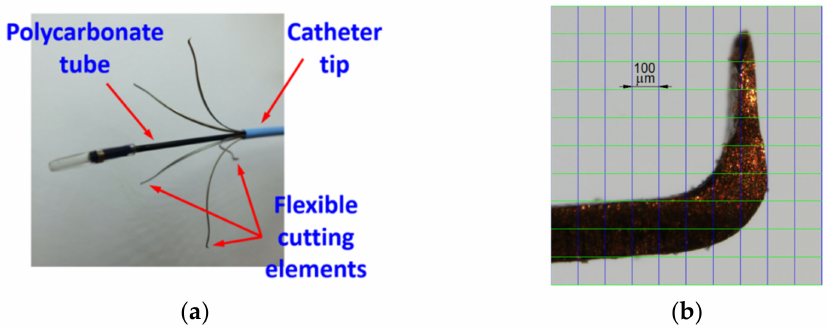
Figure 1. Flebogrif view: ( a ) Tip with five cutting elements; ( b ) Zoom-in of the cutting